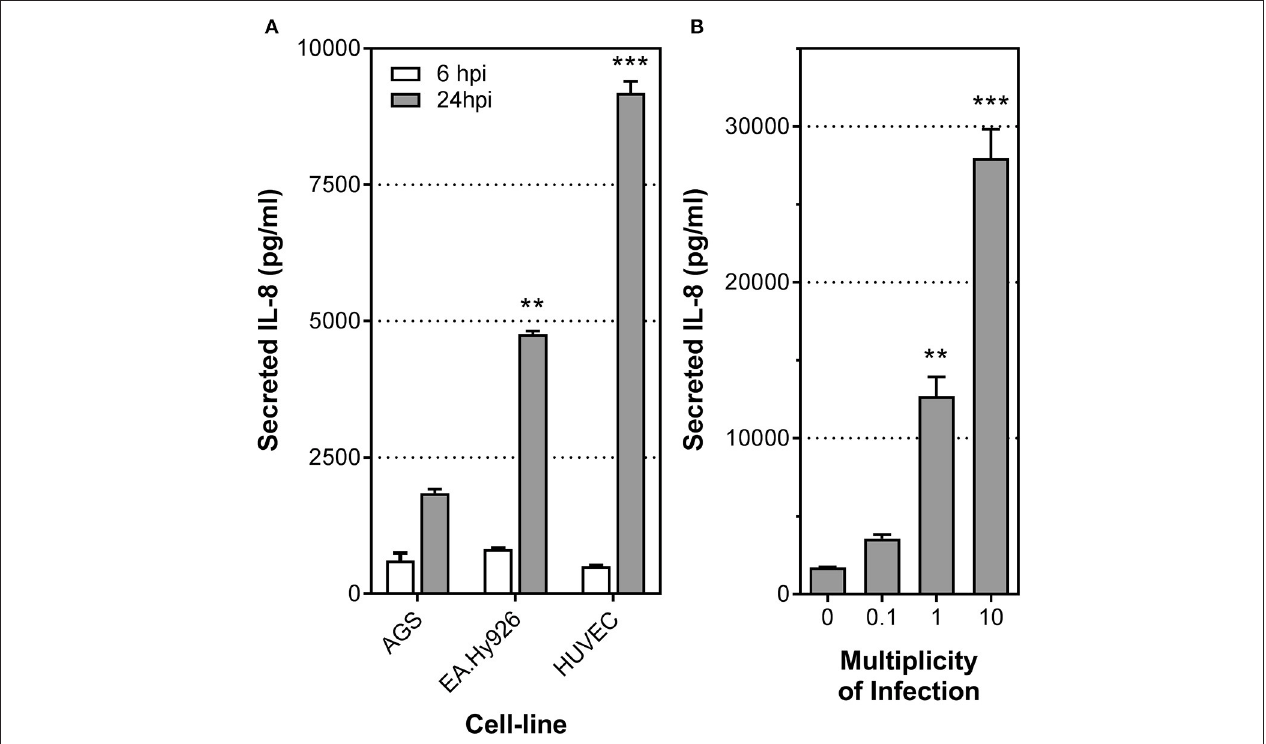
FIGURE 1 | H. pylori stimulates potent inflammatory response in human endothelial cells. (A) Mean secreted IL-8 levels in spent culture media collected at 6 and 24h post-infection (hpi) from AGS, EA.Hy925 or HUVECs infected with H. pylori P12 wild-type at MOI = 1. Error bars denote SEM; N = 2; statistical analysis using one-way ANOVA (Tukey’s multiple comparisons post-test); ** and *** denote conditions significantly different ( p < 0.005 and p < 0.001, respectively) to AGS. (B) Mean secreted IL-8 levels in spent culture media collected at 24 hpi from HUVECs inoculated with HI, or with H. pylori P12 wild-type at MOI = 0.1, 1, or 10. Error bars denote SEM; N = 2; statistical analysis using one-way ANOVA (Tukey’s multiple comparisons post-test); ** and *** denote conditions significantly different ( p < 0.005 and p < 0.001, respectively) to MOI of 0.